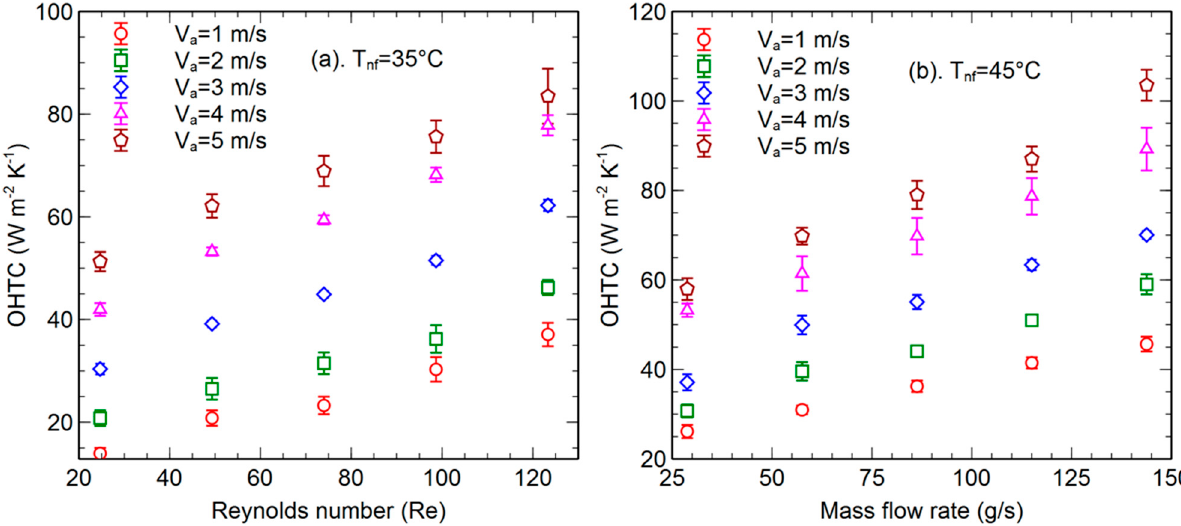
Figure 8. Variation of OHTC in an automobile radiator for various fan velocities [108].